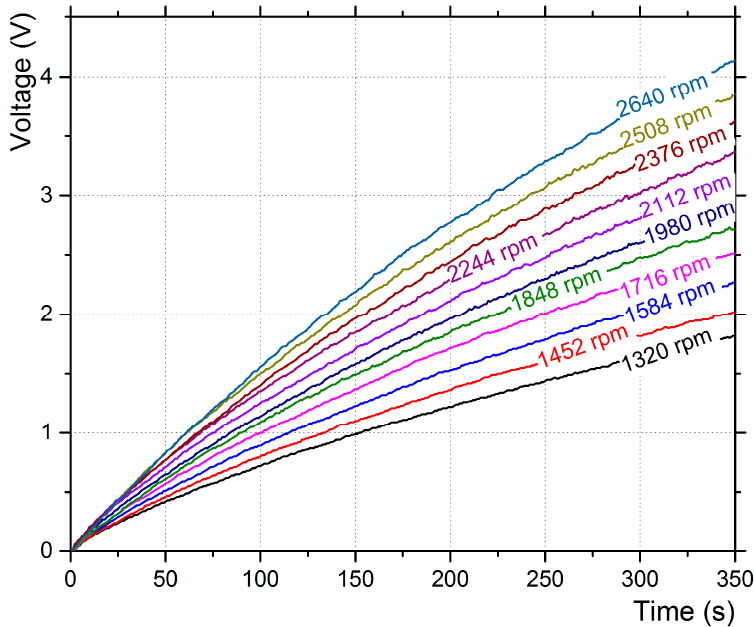
Figure 7. Voltage output to the 16 V/100 µ F capacitor for aerodynamic excitation with various fan speeds.